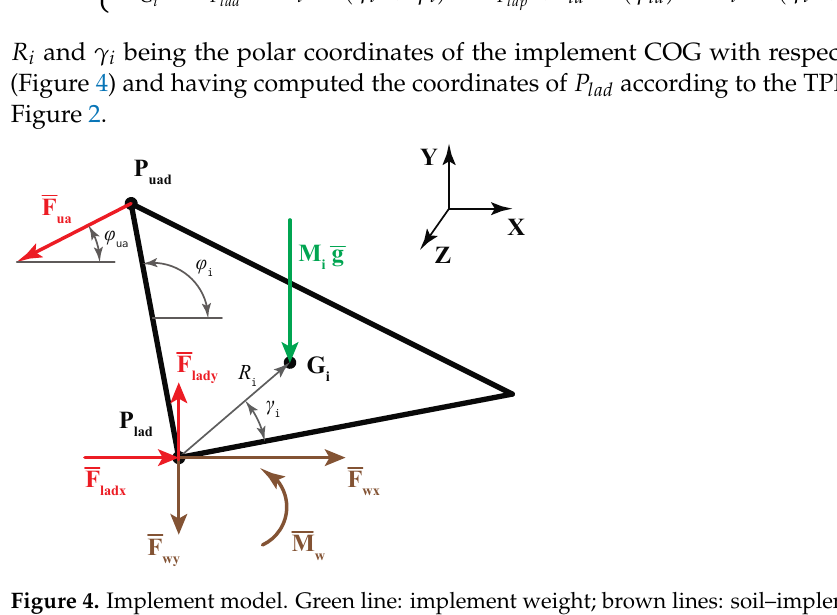
Figure 4. Implement model. Green line: implement weight; brown lines: soil – implement equivalent system of forces; red lines: TPH – implement forces.